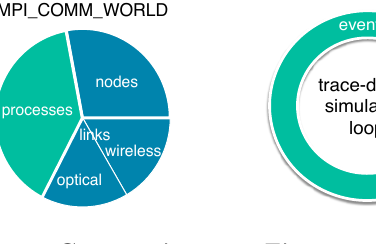
Figure 5: Next-event incrementing time ad- vance